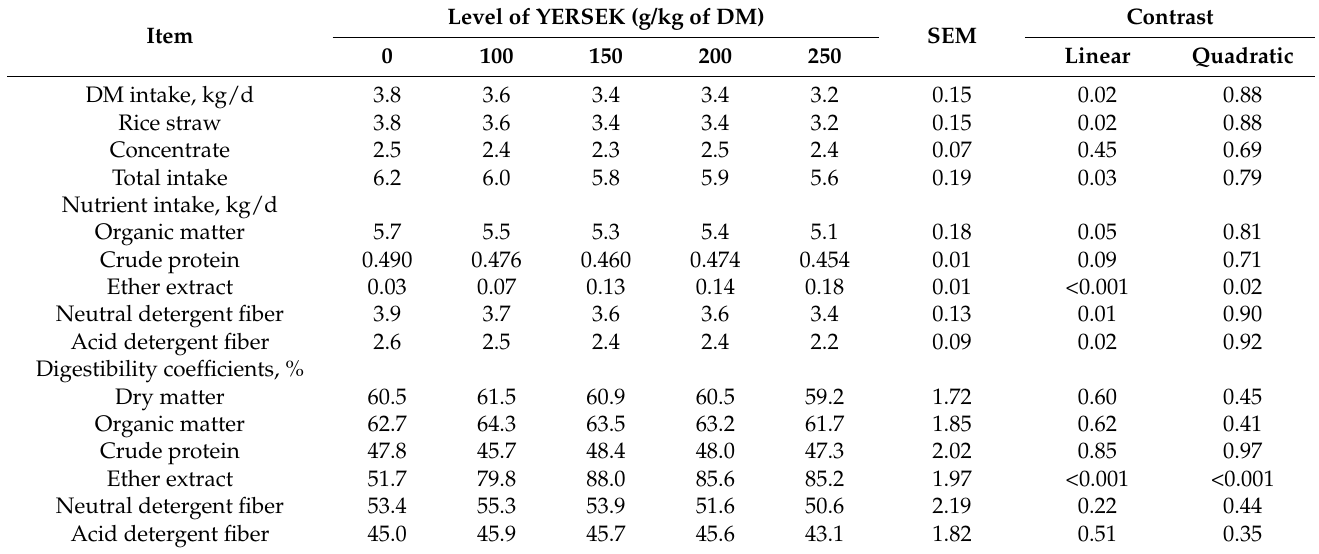
Table 3. Effect of YERSEK on feed intake and nutrient digestibility in dairy